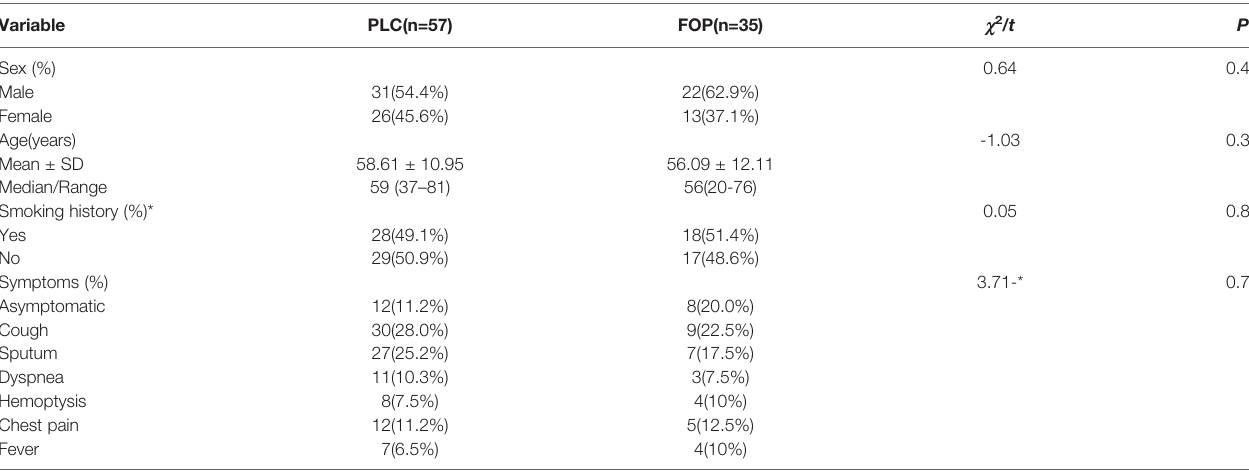
TABLE 1 | Demographic and clinical features of patients with PLC and FOP. Variable